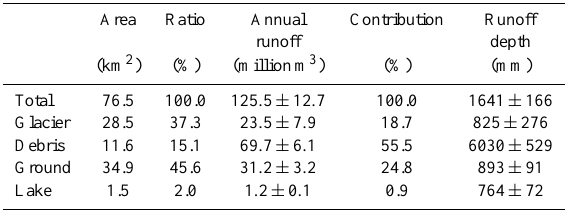
Figure 1. Tsho Rolpa Glacial Lake–Trambau Glacier basin. (a) Catchment (green line) and (b) categorized surface features with thermal resistance of debris cover. Inset box shows locations of Kathmandu (KTM), Mt. Everest (EV), and the study site. Aver- age thermal resistance is superimposed on the debris-covered area where available. Yellow cross in (a) denotes the location at which meteorological and hydrological observations were conducted in the 1990s. The background image is ASTER data taken in February 2006.